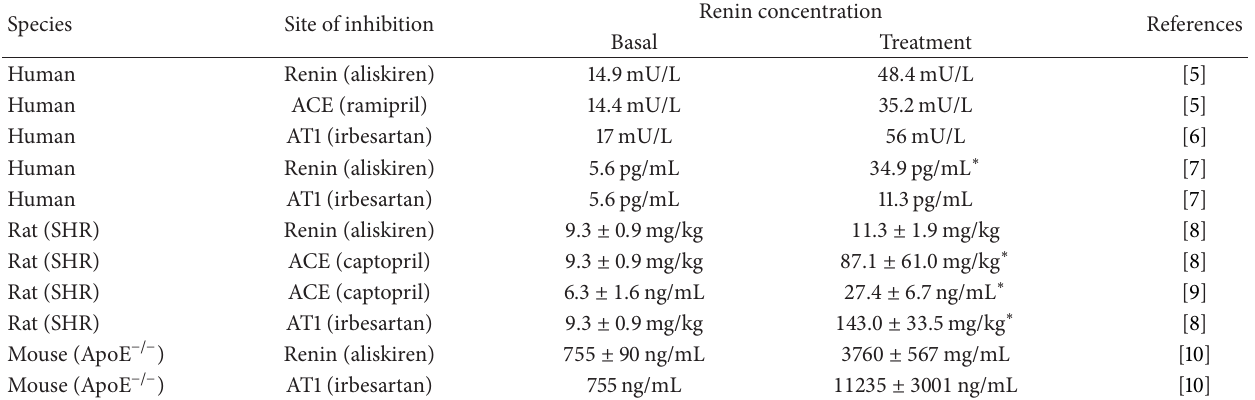
Table 1: Selected examples of the effect of pharmacological intervention at various sites of the RAAS on plasma renin concentration.